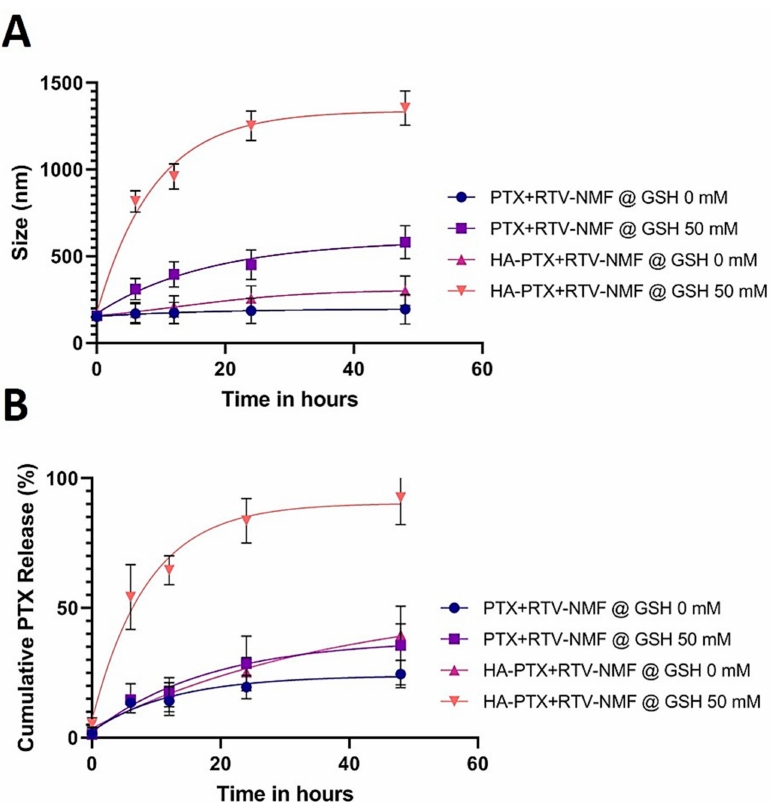
Figure 7. Nanomicelles in reduction stimulated environment under various reductive buffer conditions containing glutathione (GSH). ( A ) Determination of increase in size of HA − PTX + RTV − NMF and PTX + RTV − NMF in 50 Mm GSH in 1X PBS over 48 h. ( B ) Cumulative PTX release from HA − PTX + RTV − NMF and PTX + RTV − NMF in 50 Mm GSH in 1X PBS over 48 h. The data were expressed as mean ± SD ( n =